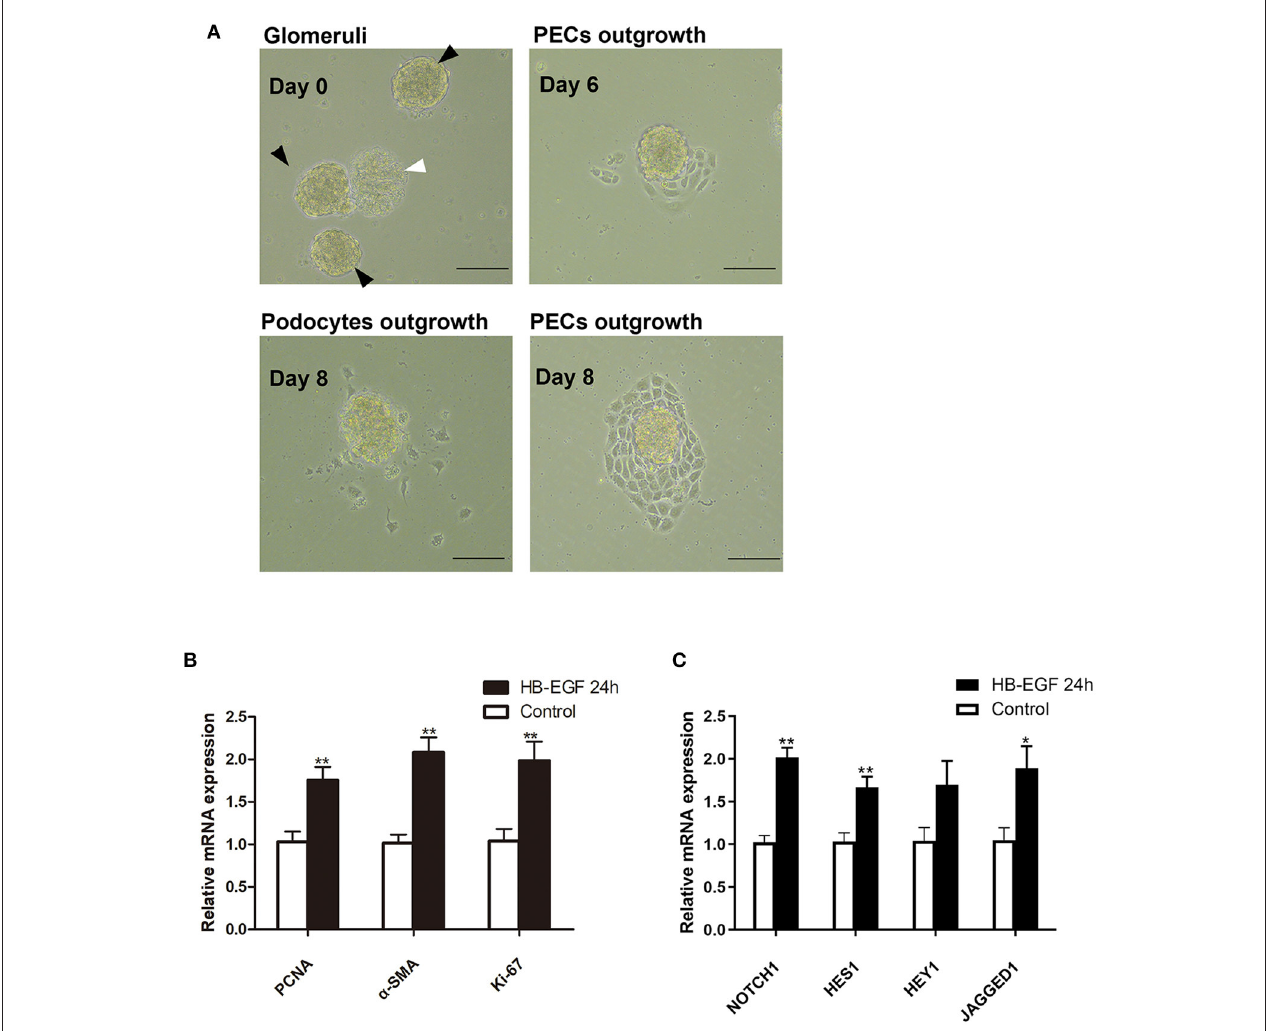
FIGURE 7 | Conditioned medium from HB-EGF-treated podocytes activated Notch signaling and enhanced proliferative activity in primary PECs. (A) Capsulated (black arrows) and decapsulated (white arrow) glomeruli were isolated from rat kidney. Primary PECs (irregularly shaped, uniform in size, and grown in clusters) outgrowing from capsulated glomeruli at day 7 were seen. (B) qRT-PCR analysis showing that the relative PCNA, α -SMA, Ki-67 mRNA expressions were significantly upregulated in the primary PECs after 24-h stimulation with conditioned medium from HB-EGF-treated podocytes (C) qRT-PCR analysis of Notch and downstream genes revealed a marked increase of mRNA in the same PECs as in (B) . All data are presented as the mean ± SD of three independent experiments. * P < 0.05, ** P < 0.01 vs. primary PECs treated with control medium from untreated podocytes. Scale bars, 50 µ